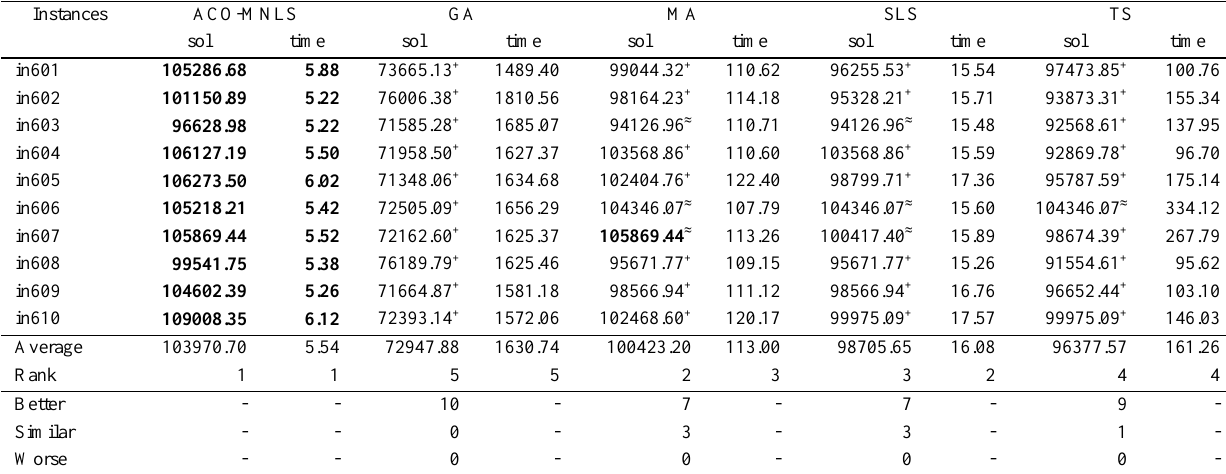
Table 6. Experimental results of proposed ACO-MNLS, GA, MA, SLS, and TS on some instances of